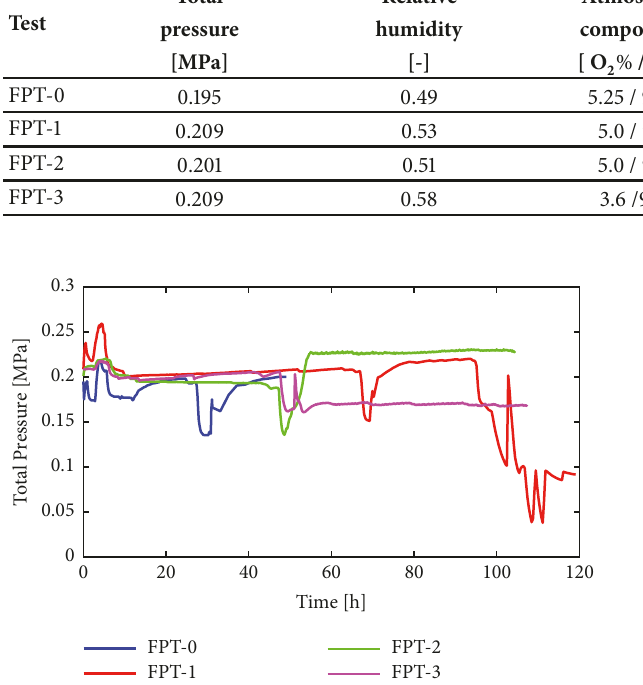
Figure 4: CV mean atmospheric temperature during the Ph´ebus FPT